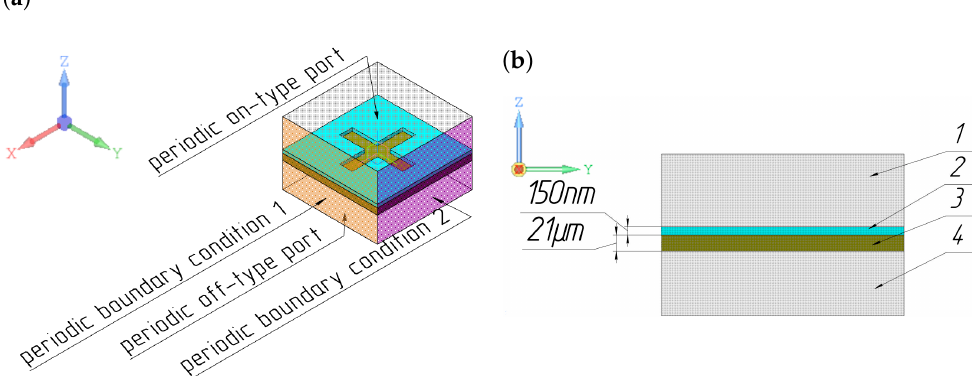
Figure 2. The geometry of the system used in the simulation ( a ) general 3-D view ( b ) side view. 1 and 4—vacuum (the height was a half of the wavelength), 2—Bi-Sb film, 3—dielectric